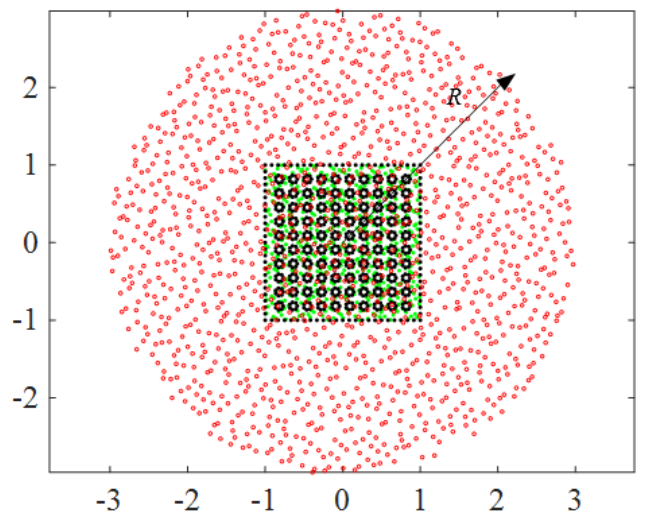
Figure 4. Node distributions of the improved RBFCM (boundary nodes “ ● ” , interior nodes “ ● ” and fictitious centre nodes “ ○ ” ).